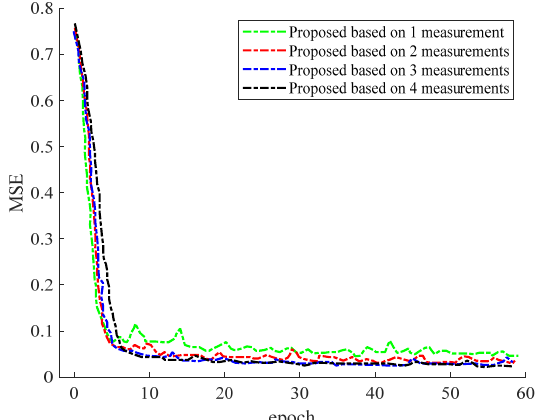
Figure 11. MSE performance of the proposed scheme (Conv-LSTM) when different numbers of inputs are used.